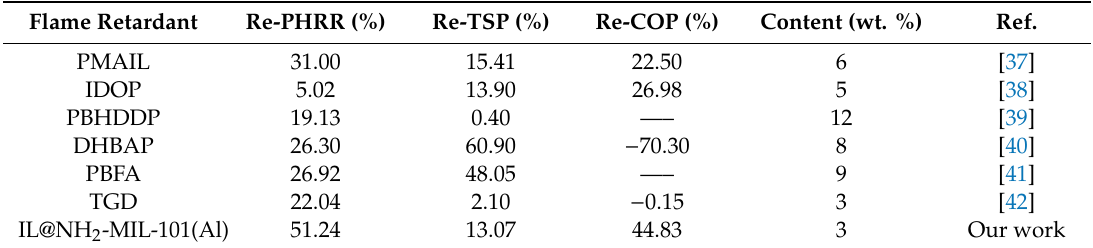
Table 4. The flame-retardant e ff ect of some other phosphorus-nitrogen-containing